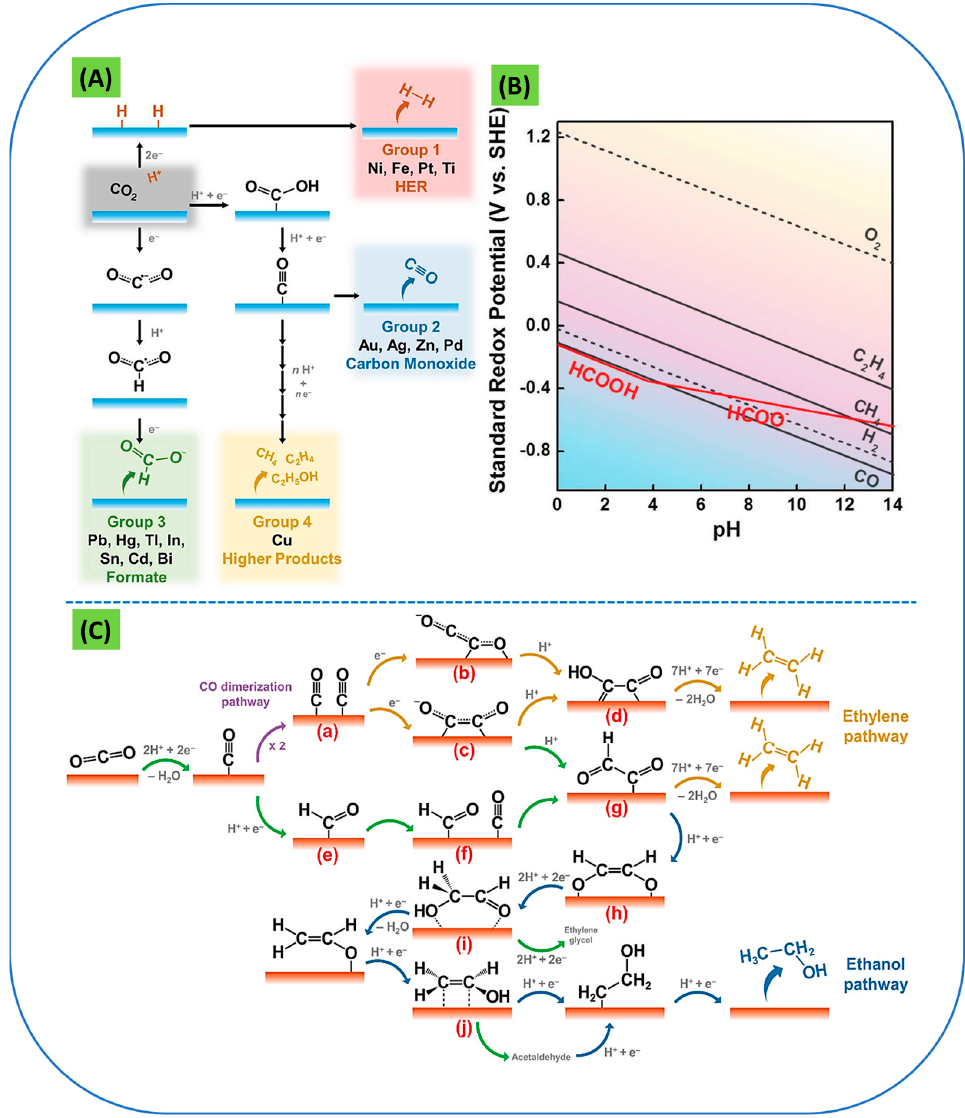
Figure 2. Representation of overall electrochemical reduction of CO 2 (ER-CO 2 ) and hydrogen evolution reaction (HER) over different groups of metal electrodes ( A ); standard redox potentials (vs. SHE) for the formation of different CO 2 -RR products ( B ) [11] (copyright: John Wiley and Sons, 2019); and reaction pathways from CO 2 to ethylene and ethanol ( C ) [10] (copyright: John Wiley and Sons, 2020).